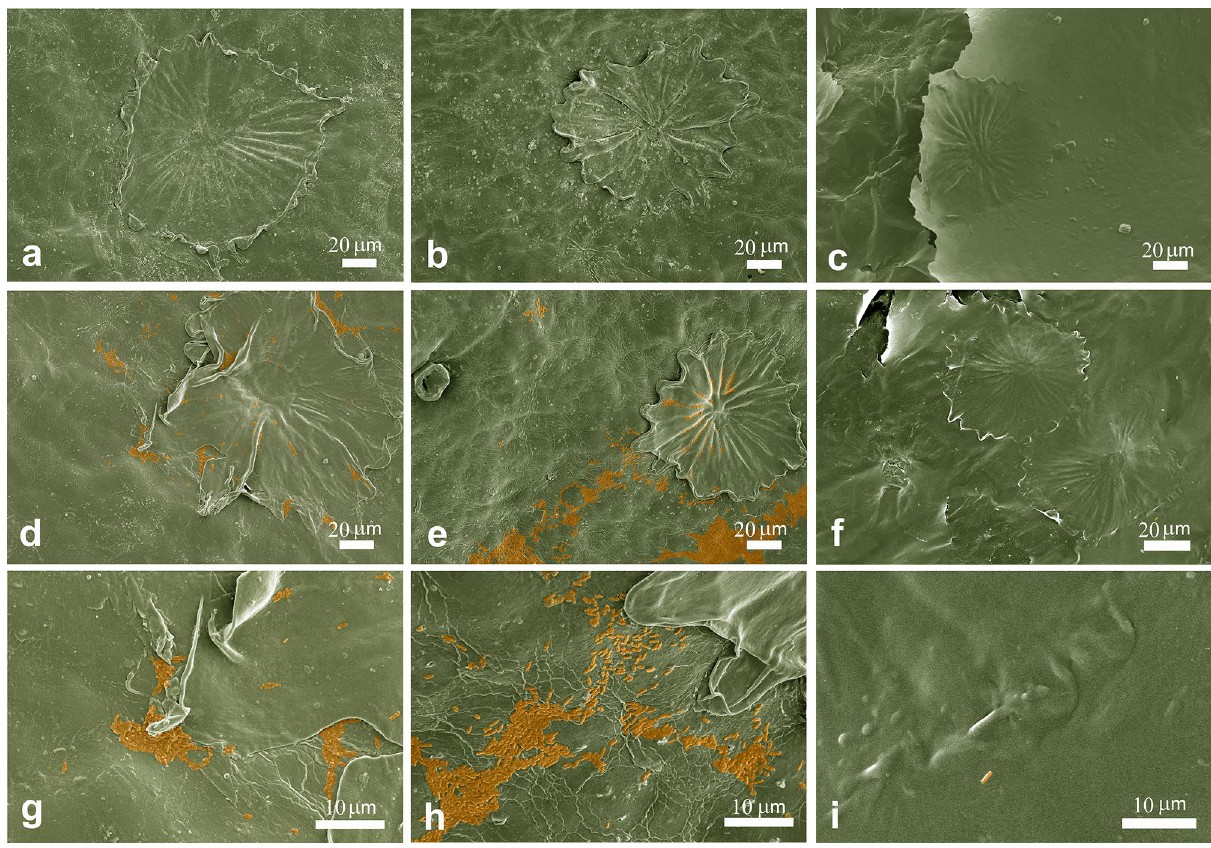
Figure 8. SEM analysis of control samples of olive leaves treated respectively with water ( a ), copper sulphate at 0.3% w/v ( b ) and CNCs suspension at 1% w/v ( c ) before the inoculation. Leaf surface showed the characteristic trichomes that were clearly distinguishable in ( a,b ), whereas were partially hided in ( c ) for the presence of the CNCs film covering the surface ( c ). After Psav inoculation of samples treated respectively with water ( d ), copper sulphate at 0.3% w/v ( e ) and CNCs suspension at 1% w/v ( f ), Psav colonies were visible as coloured areas on the leaves surface, very often located near the trichomes (1 dpi). The presence of bacteria is to be noted as